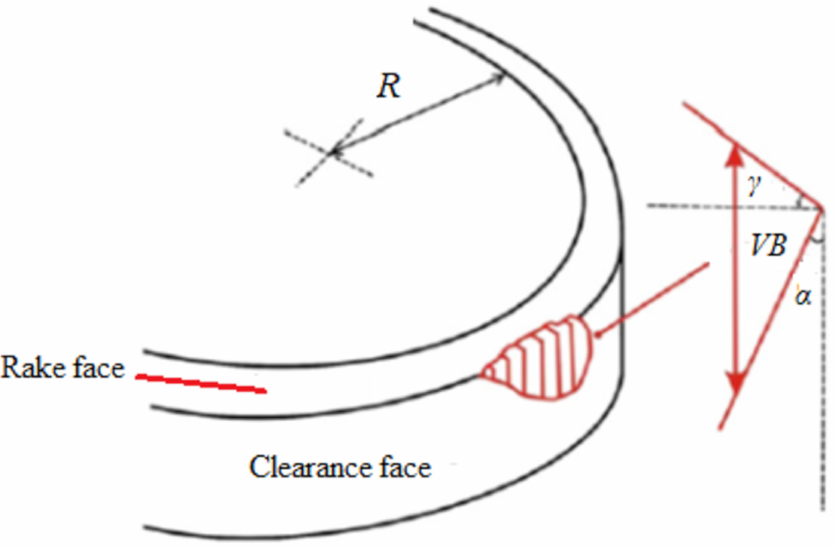
Figure 2. Cross-sectional interpretation of tool illustrating worn region based on the largest triangle